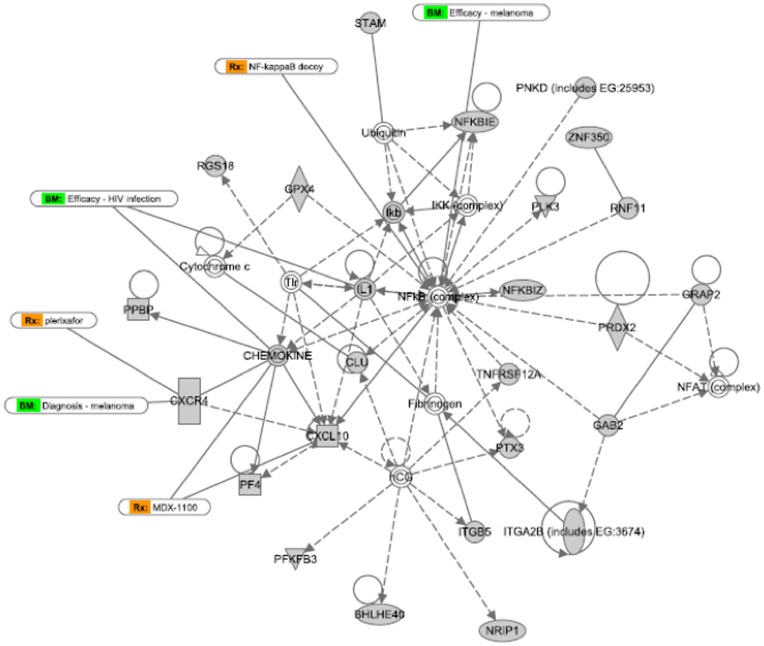
Highest scoring network after interactive network analysis of gene expression changes induced after hep-ATIII treatment of SIV-infected rhesus macaques.The highest scoring primary transcriptional network activated by hep-ATIII treatment of chronically infected rhesus macaques, at a time point when viral replication is inhibited by hep-ATIII (day 7), is shown. Rx (orange): potential medication treatment options, BM (green): possible biomarkers. Network analysis was performed using Ingenuity 8.0 software. Explanation for symbols is given in Figure S2.